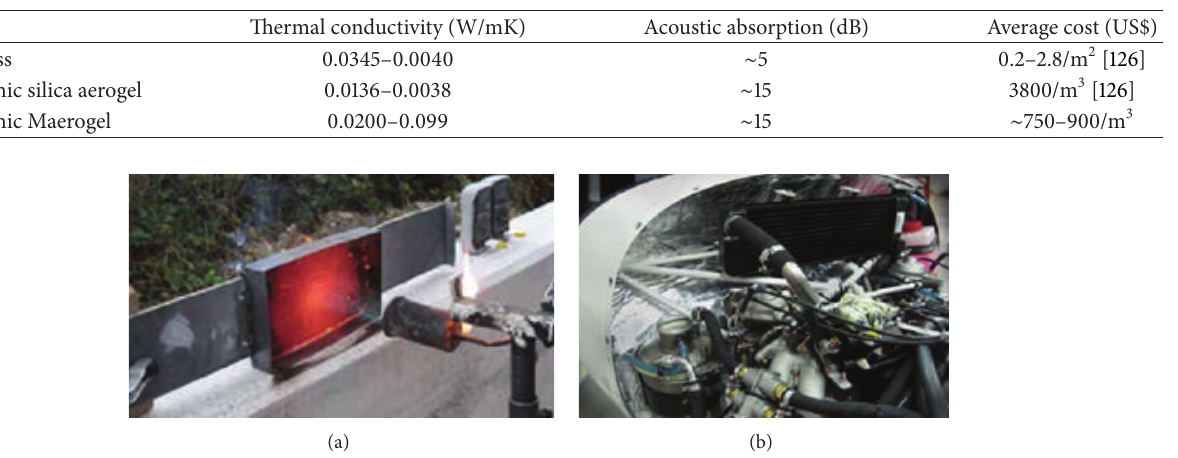
Table 4: Comparison between fiberglass, conventional silica aerogel, and Maerogel.